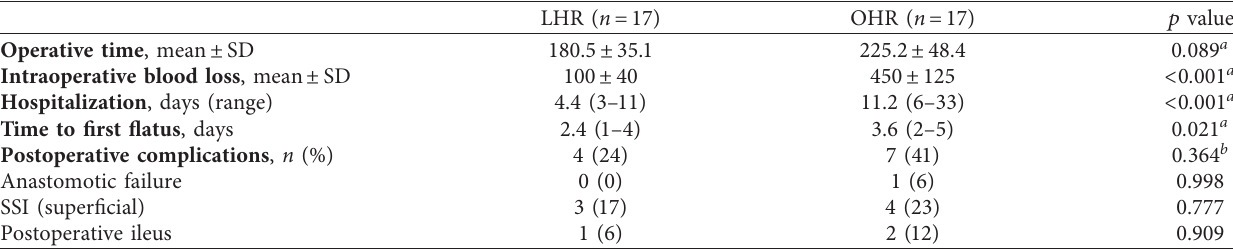
Table 2: Operative and morbidity data.